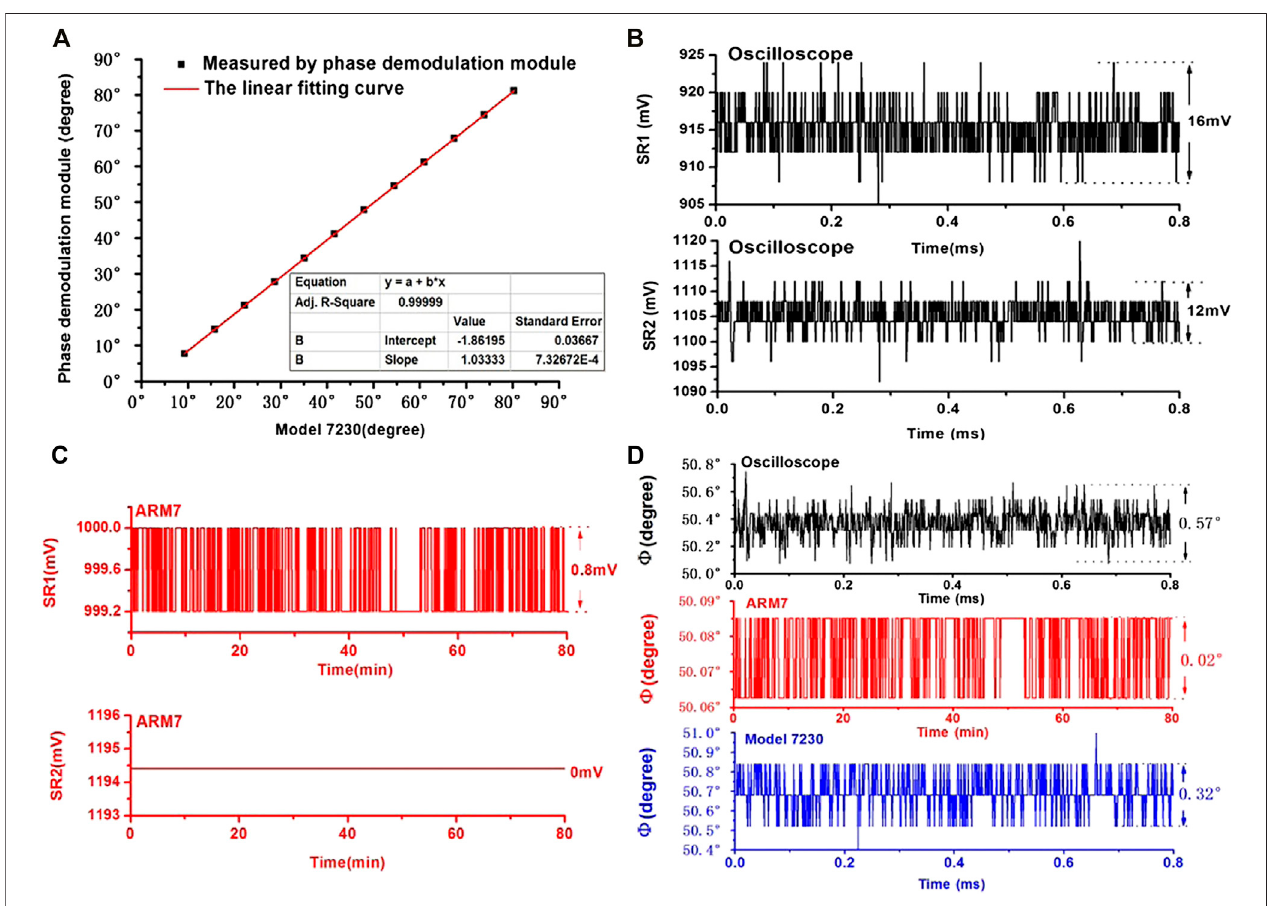
FIGURE 5 | Functional veri fi cation of the phase demodulator. (A) Phase detection linearity. (B) Signals SR1, SR2. (C) Signals S R1 , S R2 after 160,000 times of average algorithm. (D) Noise levels comparison of phase detection.